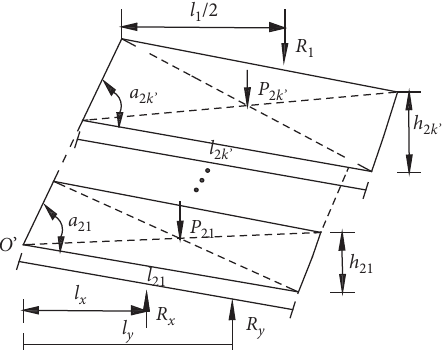
Figure 8: The model of nonhinged roof